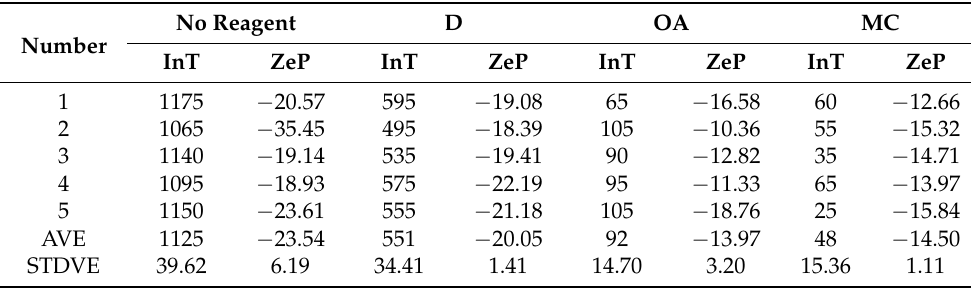
Table 2. Results of induction time and zeta potential